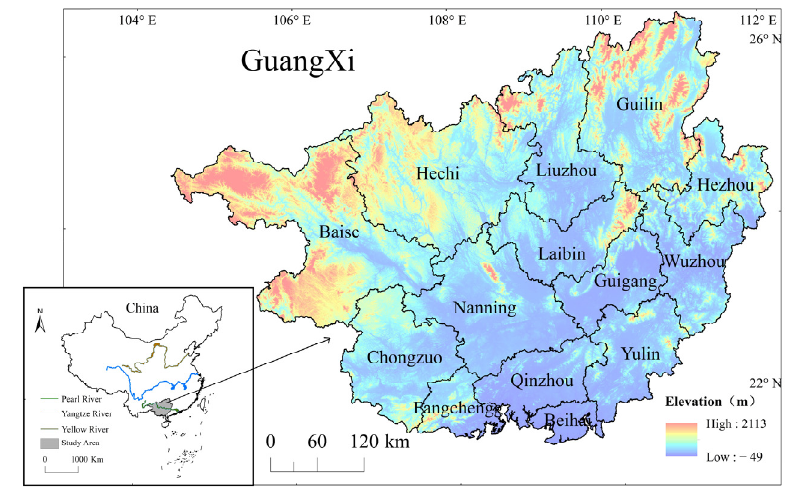
Figure 1. Study Figure 1. Study area.